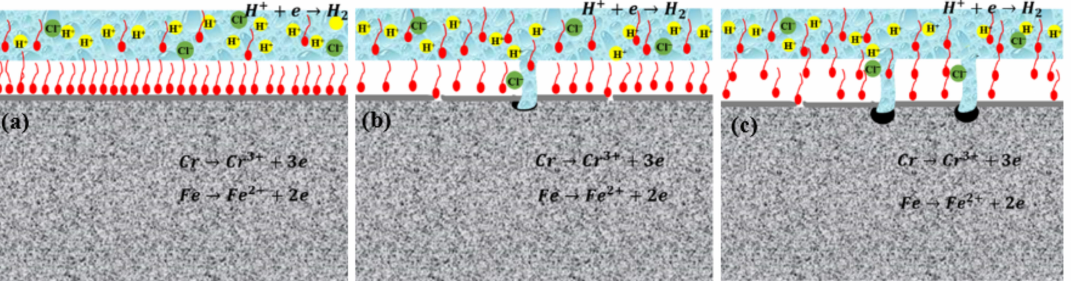
Figure 19. Schematic diagram of corrosion inhibition mechanism of acidizing corrosion inhibitor for duplex stainless steel in high-temperature and high-concentration acid solution system (( a ) 140 ◦ C, 4h ( b ) 180 ◦ C, 4 h, ( c ) 180 ◦ C, 12